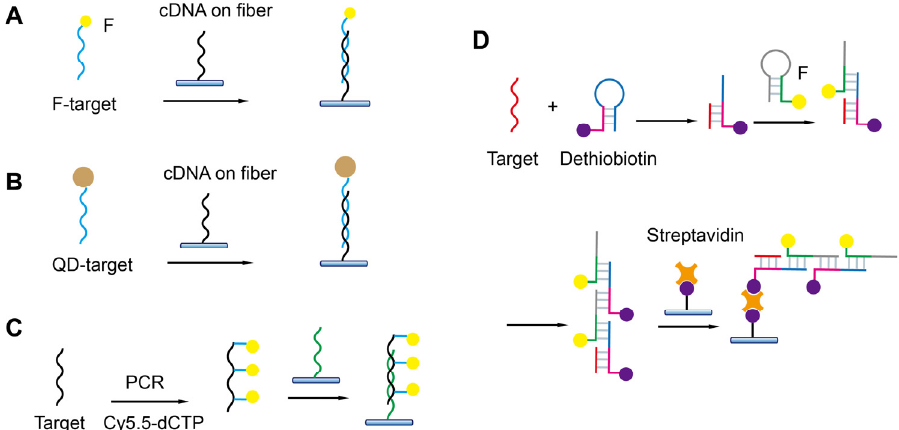
Figure 15. Schematic diagrams of FOEW sensors for detection of nucleic acids via hybridization with ( A ) single- fl uorophore Cy5.5-labeled target [107] ; ( B ) quantum-dots-labeled target [67] ; ( C ) multiple- fl uorophore-labeled target synthesized by PCR [108] ; or ( D ) multi- ple- fl uorophore-labeled duplex formed via hybridization reaction (HCR) [109] .